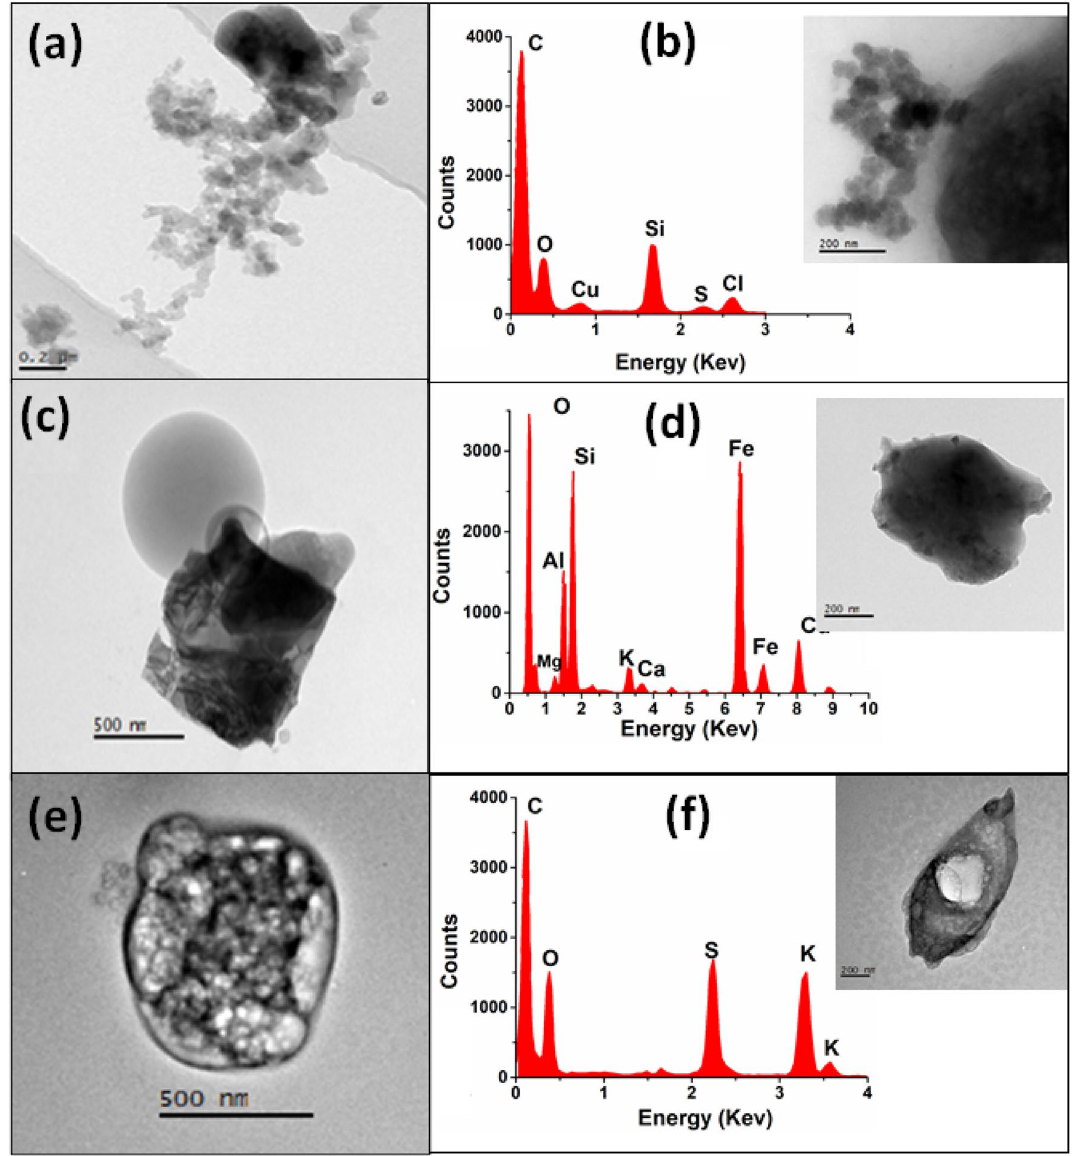
Figure 8. High-magnification TEM micrographs and EDS spectra for ( a ) and ( b ) soot aggregates; ( c ) and ( d ) mineral dust; ( e ) and ( f ) S-rich